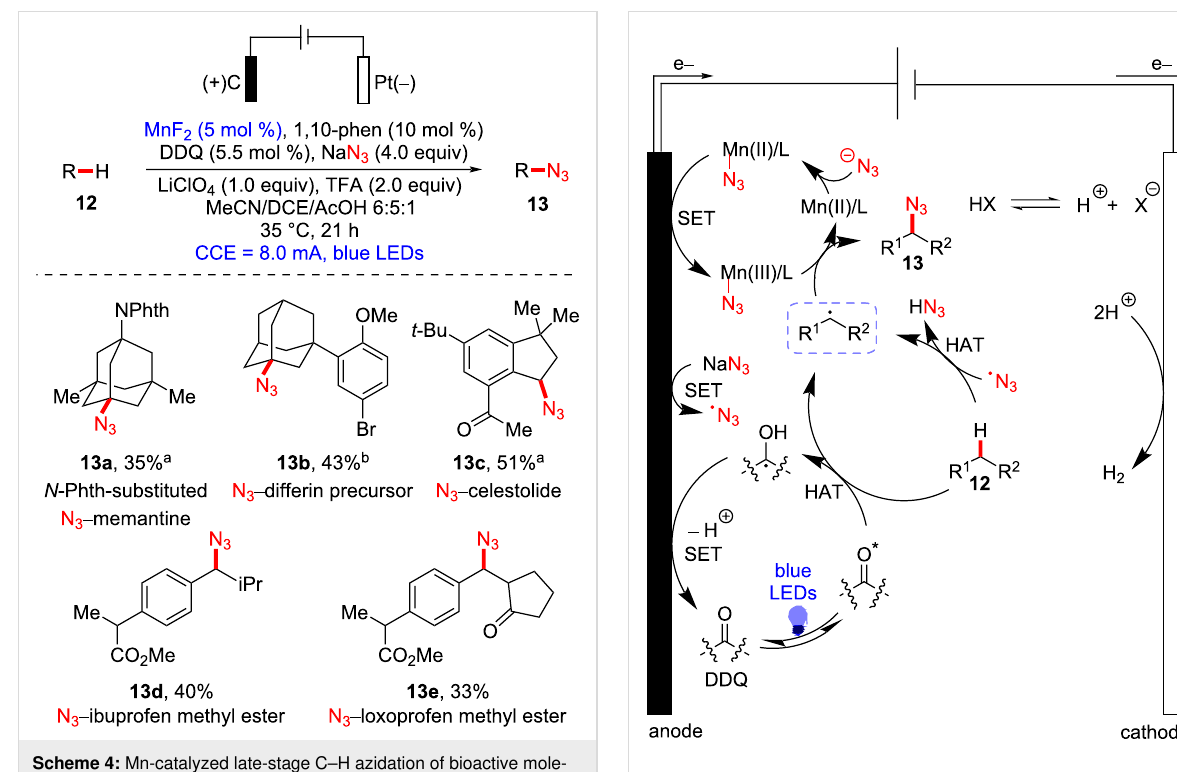
Figure 4: Proposed reaction mechanism of electrophotocatalytic